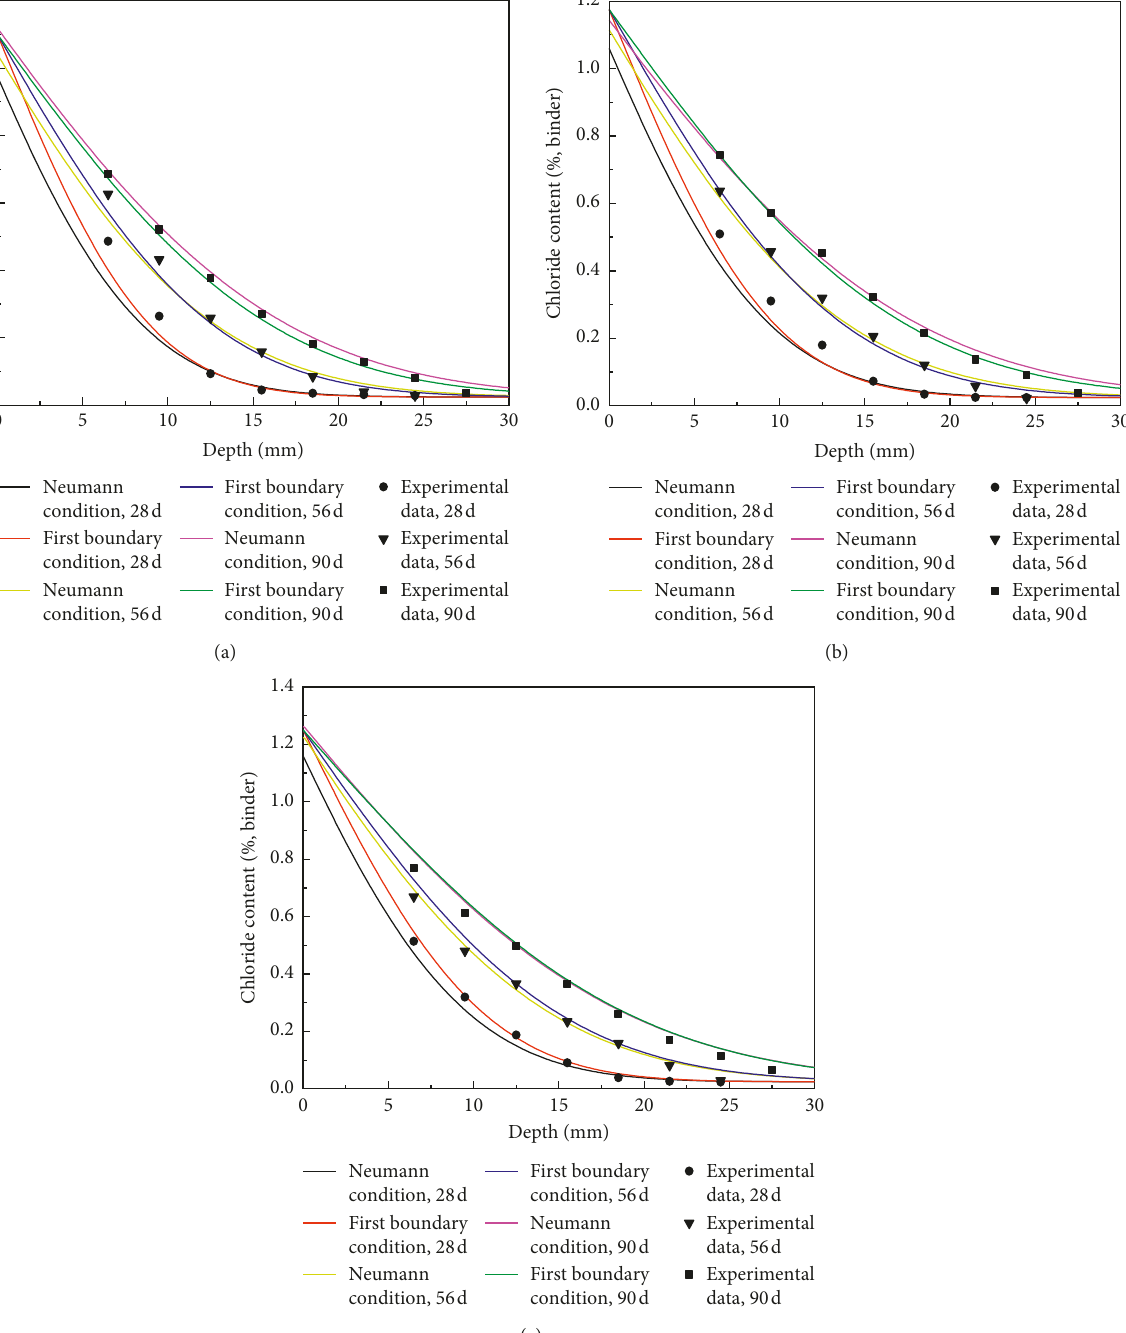
Figure 8: Chloride profile over time obtained from experimental data and model in the present study: (a) w/b � 0.4; (b) w/c � 0.45; (c) w/b �